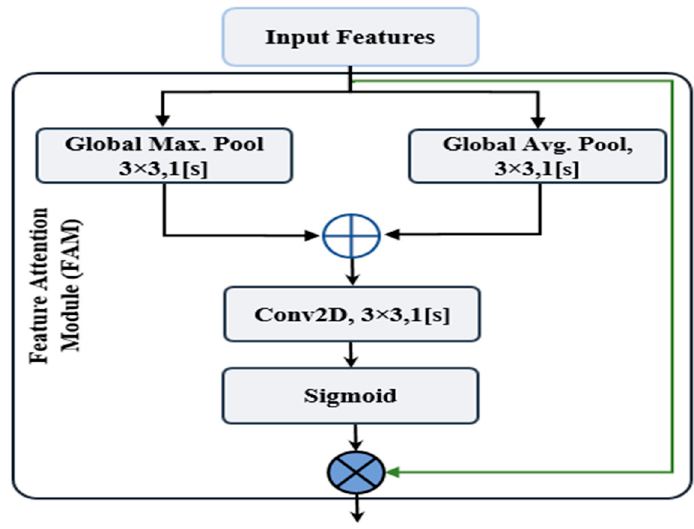
Figure 5. The FAM’s schematic diagram.